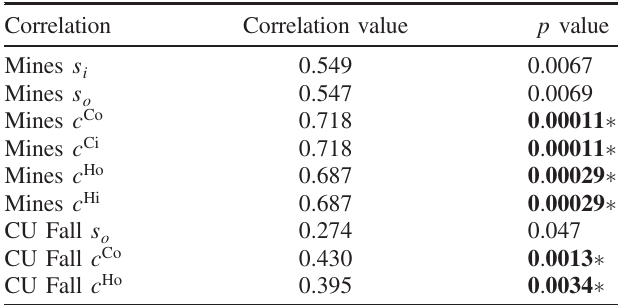
TABLE II. A summary of the application of the Bonferroni test to the significance levels of the measured correlations between student centrality (listed in the first column) and homework scores. p values for correlations that satisfy the Bonferroni test are indicated in bold with asterisks, meaning that these correla- tions are less susceptible to type I